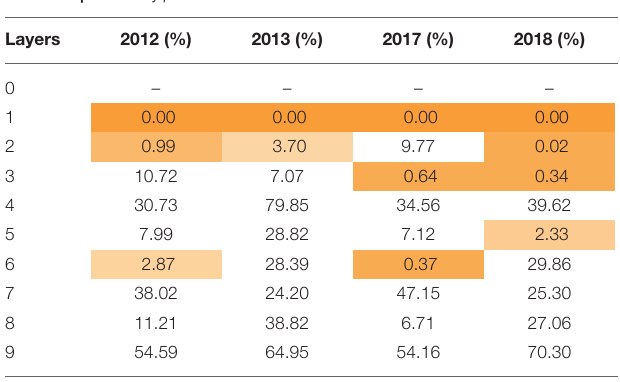
TABLE 4 | Accuracy p -value. Layers